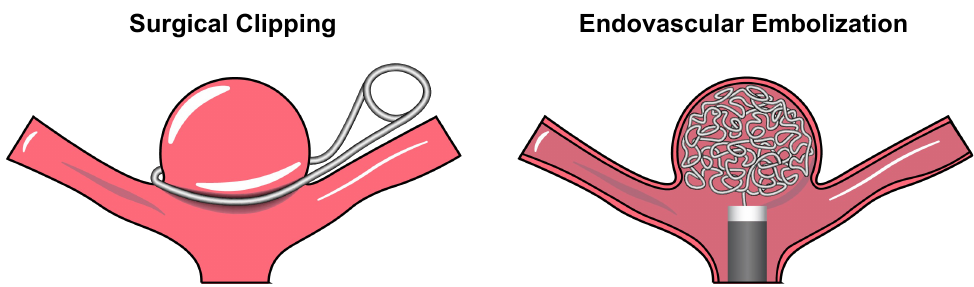
Figure 1. Schematic of the two primary aneurysm treatment methods: (i) surgical clipping (the metal clip not drawn to scale) ( left ); and (ii) endovascular embolization using Guglielmi detachable coils (GDCs) ( right